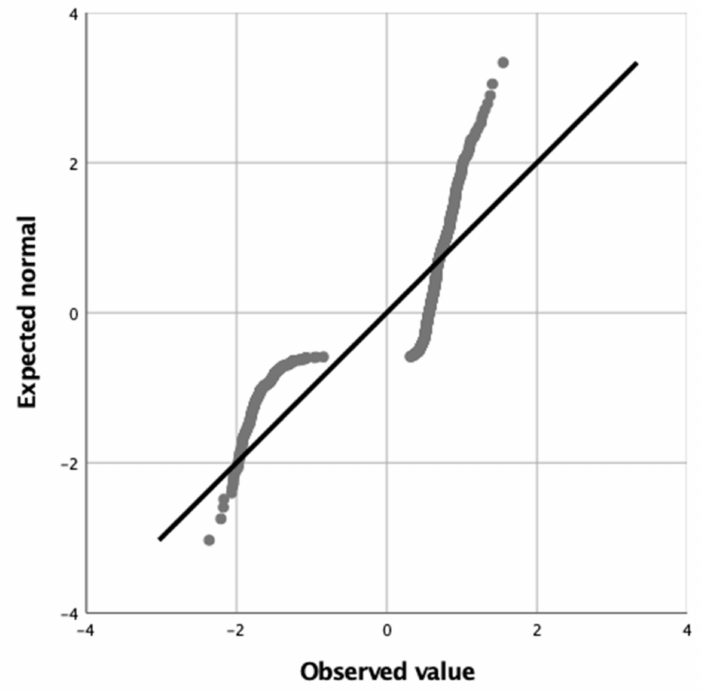
Figure 2. Probability plot showing the distribution of the deviance residuals.